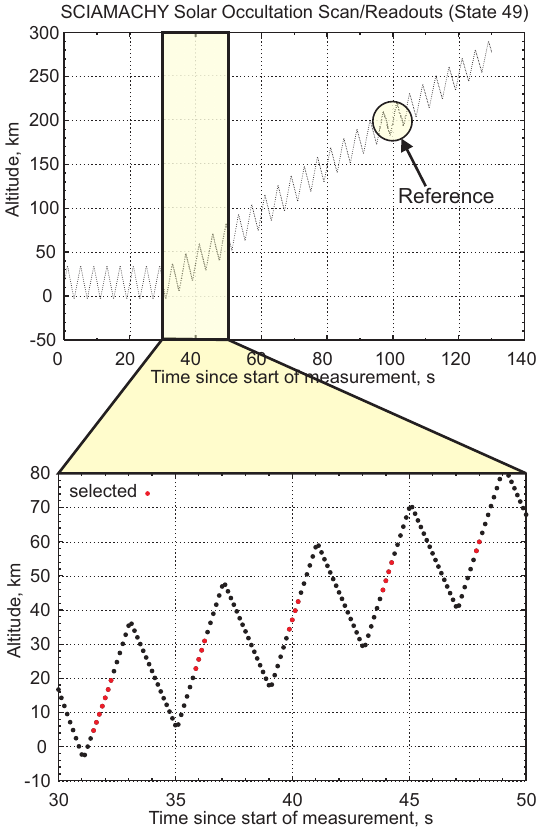
Fig. 4. Tangent altitudes of channel 5 readouts during a typical SCIAMACHY solar occultation measurement. Only those altitudes marked by red points are used in the retrieval. Reference spectra ( I 0 ) are taken from the upward scan around 100s after the start of the measurement in about 200km